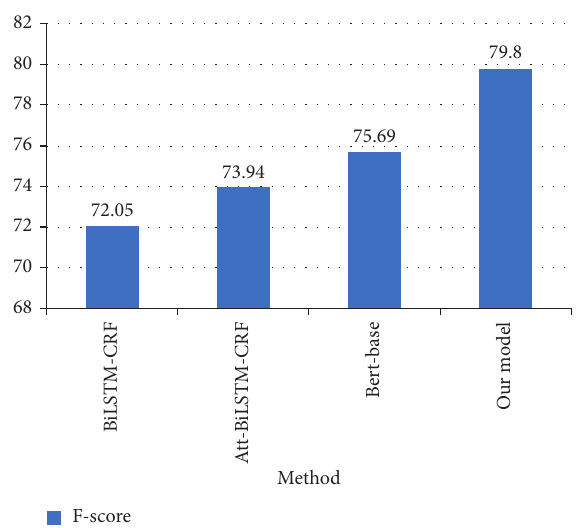
Figure 3: F-score of different